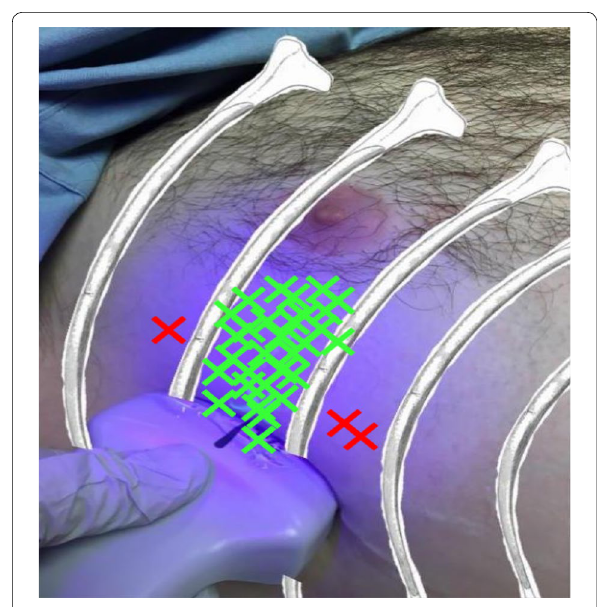
Fig. 4 This is an illustrative representation of the data plotted on the volunteer’s chest wall for the ultrasound-guided method. The green “X’s” represent the correct intercostal space, whereas the red “X’s” demonstrate the number of participants who did not place the transducer in the correct ICS. The data plotted were illustrated and represented in rib spaces above and below the target